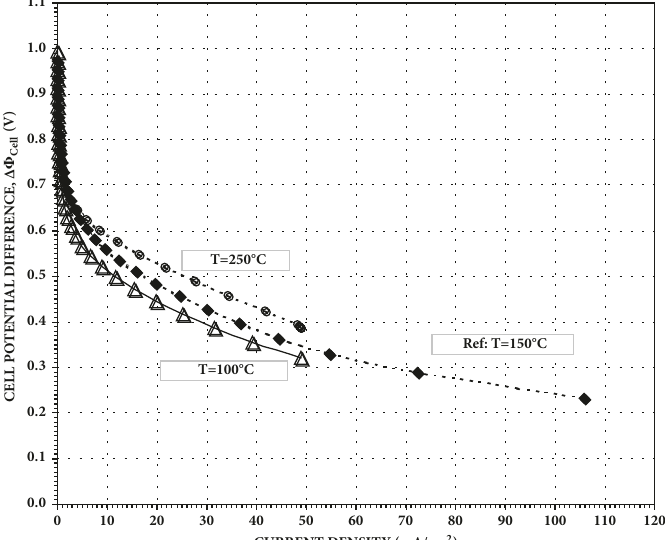
Figure 12: The effect of the fuel cell operating temperature, T ( ∘ C), on the polarization curve for a direct propane fuel cell (DPFC) model at 1 atm. The values of T ( ∘ C) for the above three cases were represented by the following symbols: (i) open circles: 250 ∘ C, (ii) solid diamonds: 150 ∘ C (reference case), and (iii) open triangles: 100 ∘ C. All the other parameters were the same as the reference case mentioned in Table